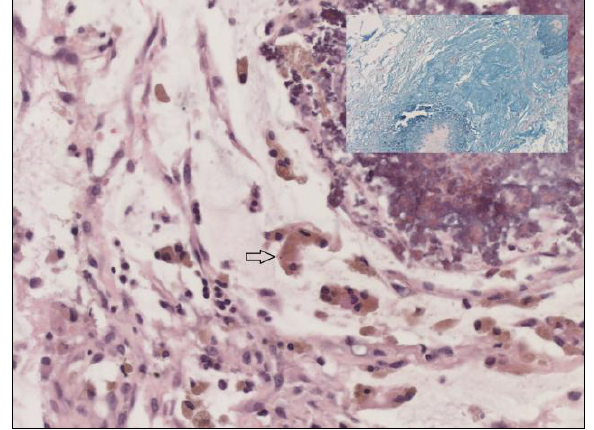
Figure 1: Histological images of omental mass excised during inguinal herniotomy in our patient displaying omentum with meconium-laden macrophages (arrow), Haemotoxylin and Eosin stain, magnification X40; [Inset displaying mucin, stained with Alcian blue, magnification